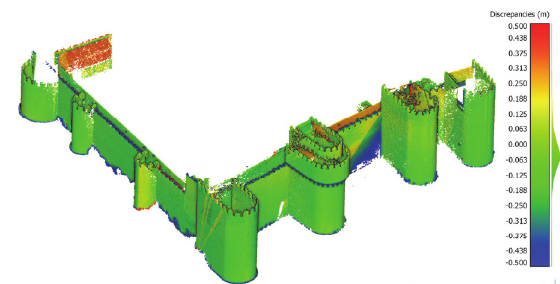
Figure 7. Spatial view of the signed discrepancies in the Alcázar Gate and its surroundings.